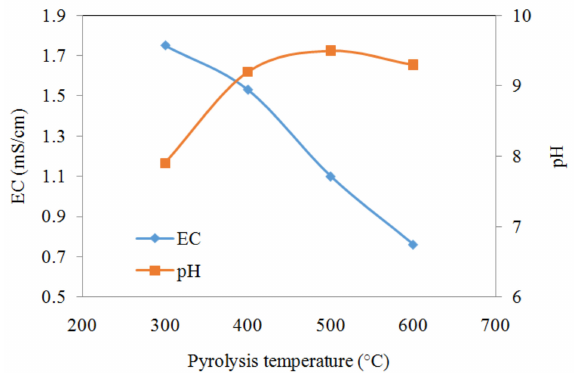
Figure 1. pH and EC variation of the biochars when the pyrolysis temperature was increased from 300 to 600 ◦ C.